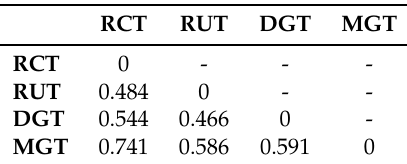
Table 2. Dissimilarity matrix among the different treatments. The entries are 1 minus the correlation between two methods and thus represent dissimilarity coefficients. Higher numbers indicate more inconsistency in subjects’ behavior between two methods.